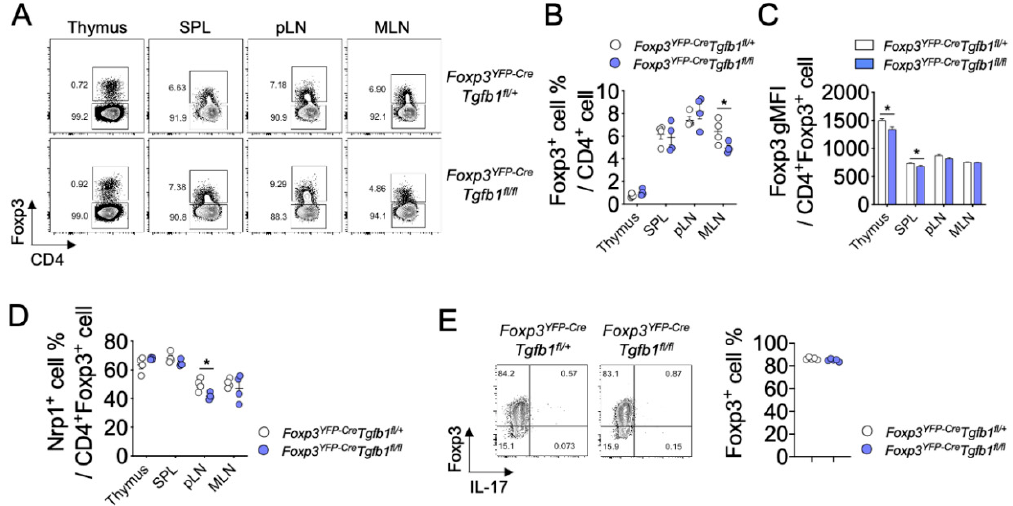
Figure 1. Autocrine TGF- β 1 is dispensable for the development and differentiation of Treg cells. ( A ) Flow cytometric analysis of Foxp3 expression in CD4 + T cells from the thymus, spleen (SPL), peripheral lymph nodes (pLN), and mesenteric lymph nodes (MLN) of Foxp3 YFP-Cre Tgfb1 fl/+ and Foxp3 YFP-Cre Tgfb1 fl/fl mice at 8 weeks ( n = 4). ( B , C ) Graph depicting the frequency and geometric mean fluorescence intensity (gMFI) of Foxp3 + cells among gated CD4 + cells from thymus, SPL, pLN and MLN ( n = 4). ( D ) Expression of Nrp1 in CD4 + Foxp3 + cells from thymus, SPL, pLN, and MLN ( n = 4). ( E ) Naïve T cells from Foxp3 YFP-Cre Tgfb1 fl/fl and control mice were differentiated to Treg cells in vitro for three days and analyzed for the expression of Foxp3 by flow cytometry. Data are representative of three ( E ) or four ( A – D ) independent experiments. Quantification plots show mean ± SD ( B , D , E ) and mean + SEM ( C ). * p ≤ 0.05 based on two-tailed Student’s t -test.